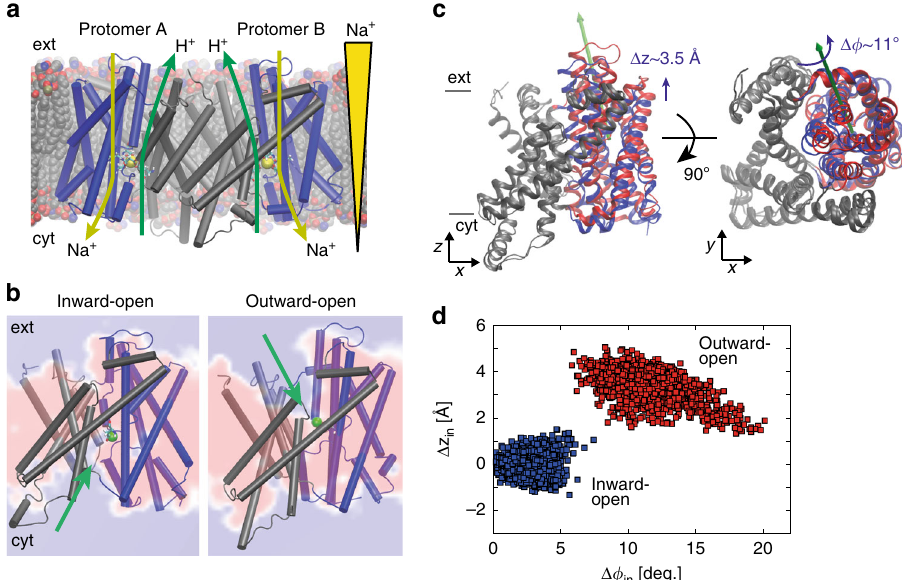
Fig. 1 Alternating-access transport in PaNhaP. a Inward-open dimer with bound Na + ions (yellow spheres) embedded in a lipid bilayer. Arrows indicate gradient-driven Na + import (yellow) coupled to H + export (green) from the cytosol (bottom) to the exterior (top). b Inward- and outward-open structures of protomers A and B, respectively, with a section through the average water density in the 1- μ s free MD simulation of the asymmetric dimer (red: no water; blue: water at bulk density). The green sphere indicates H δ of the protonated Asp159, and the green arrows its water accessibility. c Motion of six- helix-bundle transporter domains between inward-open (blue) and outward-open states (red), after superposition of the dimerization domains (gray) of the respective average structures. Left: Translation normal to membrane in side view; right: domain rotation (axis indicated by green arrow) seen from above. d Projection of the 1- μ s equilibrium MD run of the asymmetric dimer onto the plane of vertical displacement Δ z in and rotation angle Δ ϕ in relative to the inward-open structure (blue: inward-open protomer A; red: outward-open protomer B)